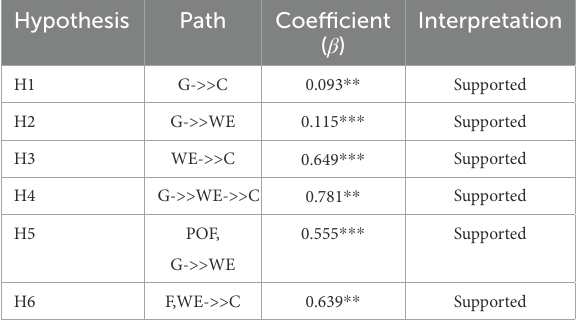
TABLE 5 Summary of path analysis/hypotheses results